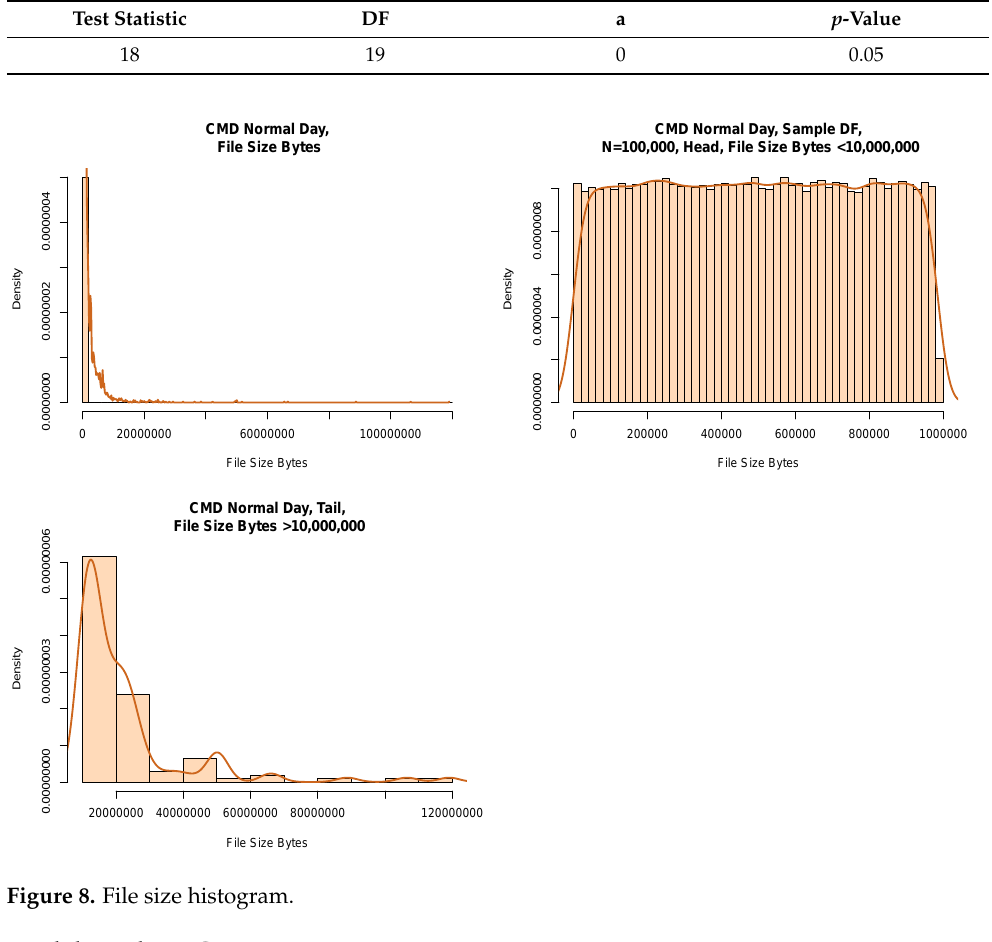
Table 8. File size, head, Chi-square uniform distribution test.